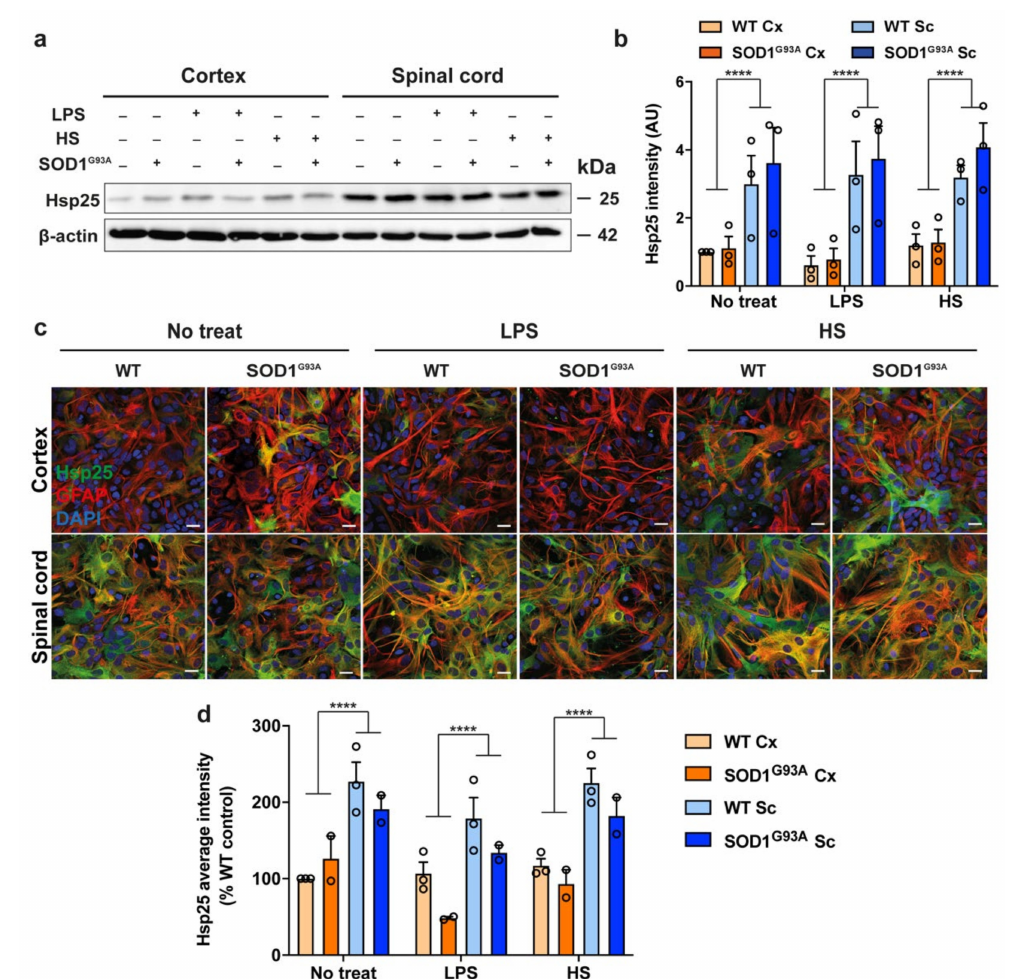
Figure 4. Hsp25 expression in SOD1 G93A mixed glial cultures derived from the cortex and spinal cord. Mixed primary cortical and spinal cord glia were either treated with LPS (80 µ g/mL) or heat shocked (42 ◦ C/30 min followed by recovery at 37 ◦ C/24 h). Cells were then harvested for immunoblotting or fixed, permeabilised and immunolabelled for GFAP and Hsp25 and analysed by fluorescence microscopy. ( a , b ) Immunoblotting, quantification and fold change of Hsp25 (25 kDa) levels in whole-cell lysates relative to β -actin in cortical and spinal cord samples. ( c ) Immunofluorescence of mixed glial cultures immunolabelled for Hsp25 and GFAP and counterstained with DAPI. Scale bar = 20 µ m. ( d ) The average intensity of Hsp25-AF488 staining normalised to WT cortical control in cortical and spinal cord samples. Data shown are the means ± SEM of 2–3 independent experiments. Statistically significant differences between the means were assessed using a two-way ANOVA followed by Bonferroni’s post hoc test, where p < 0.0001